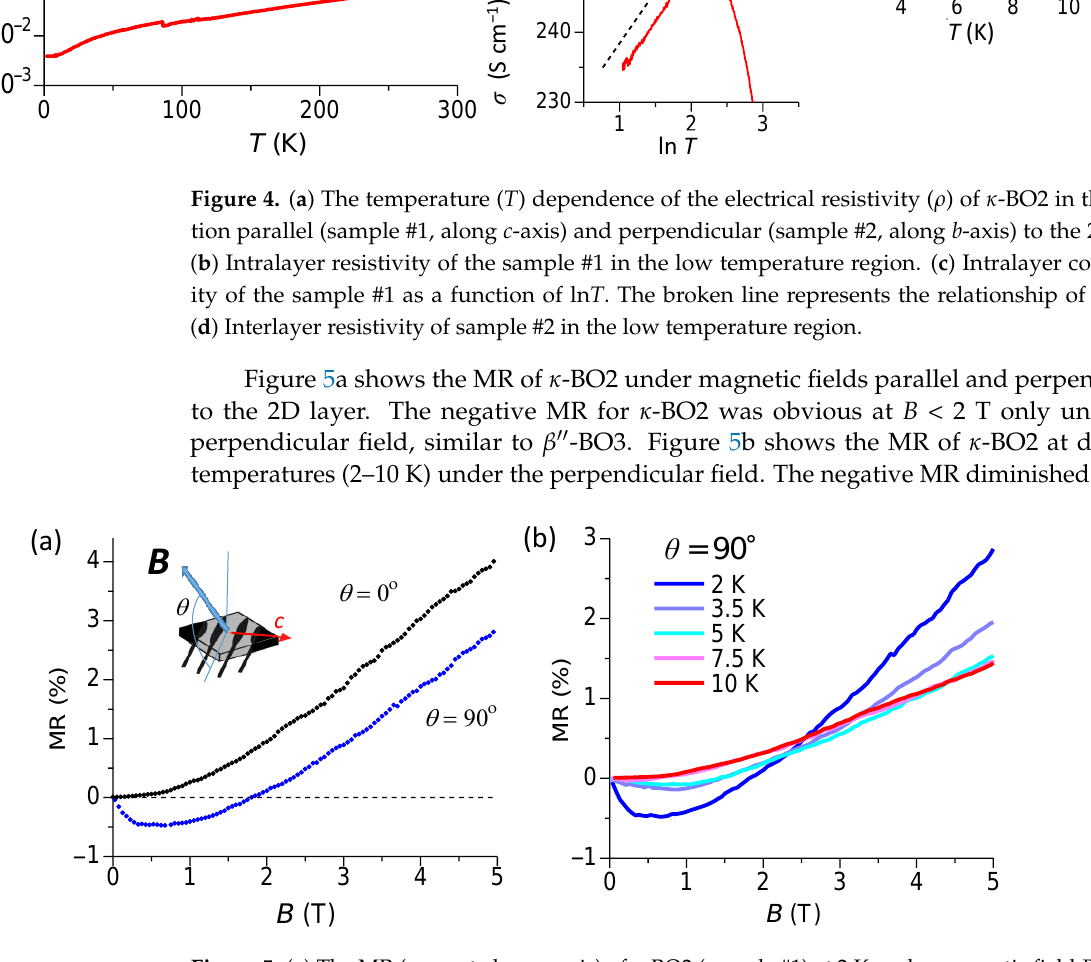
Figure 5. ( a ) The MR (current along c -axis) of κ -BO2 (sample #1) at 2 K under magnetic field B parallel ( θ = 0 ◦ ) and perpendicular ( θ = 90 ◦ ) to the 2D layer. Clear negative MR was observed when θ = 90 ◦ . ( b ) The MR for the perpendicular field in the temperature range of 2 – 10 K.